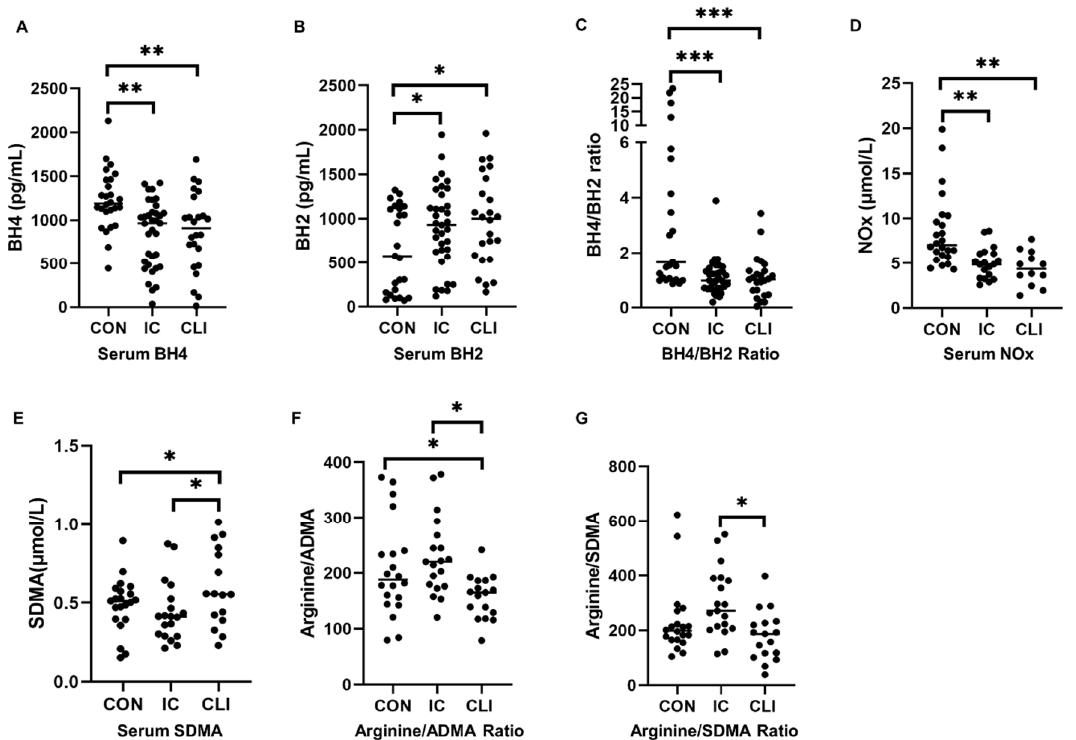
Figure 1. Levels of nitric oxides (NOx) and regulators of nitric oxide (NO) synthesis. The concentrations of these compounds were measured in the sera of patients with intermittent claudication (IC), critical limb ischemia (CLI), and non-peripheral artery disease (PAD) controls. ( A ), tetrahydriopterin (BH4) concentrations; ( B ), dihydrobiopterin (BH2) concentrations; ( C ), the ratio of BH4 / BH2; ( D ), NOx concentrations; ( E ), symmetric dimethylarginine (SDMA) concentrations; ( F ), the ratio of arginine / asymmetric dimethylarginine (ADMA); ( G ), the ratio of arginine / SDMA. Bars indicate median, and p values were calculated by analysis of covariance (ANCOVA) test. * represents p < 0.05, ** represents p < 0.01, *** represents p < 0.0001.